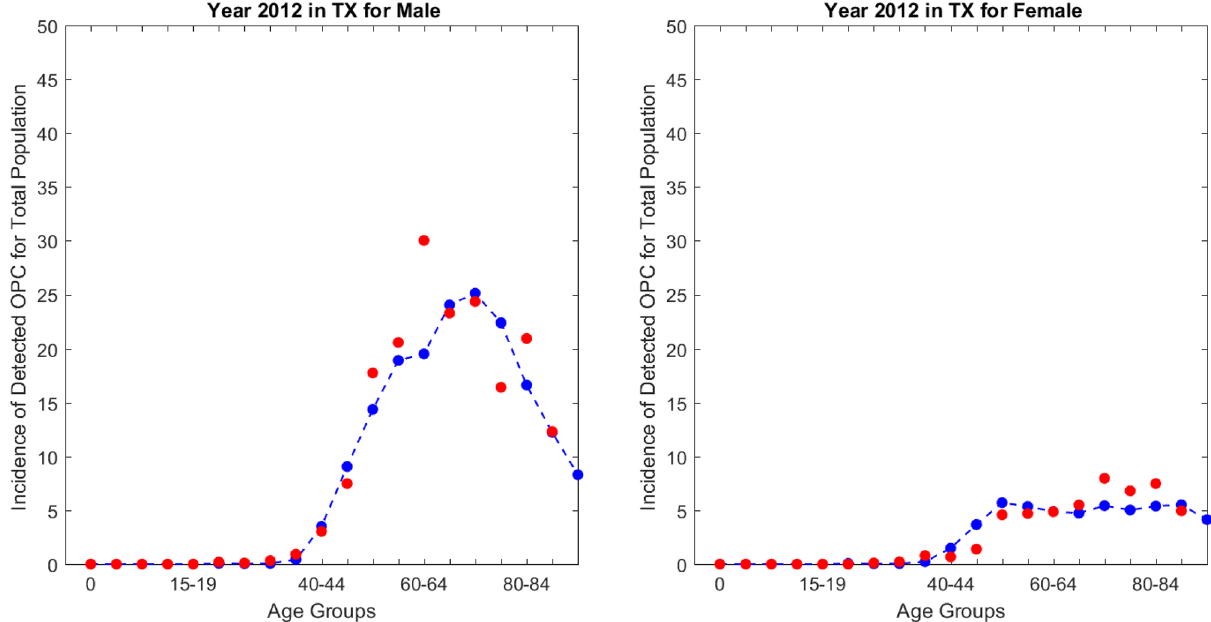
Figure 1. Model validation using real 2012 oropharyngeal cancer (OPC) incidence data for males and females in Texas (TX). Red points denoted real values and blue points denoted predicted values.